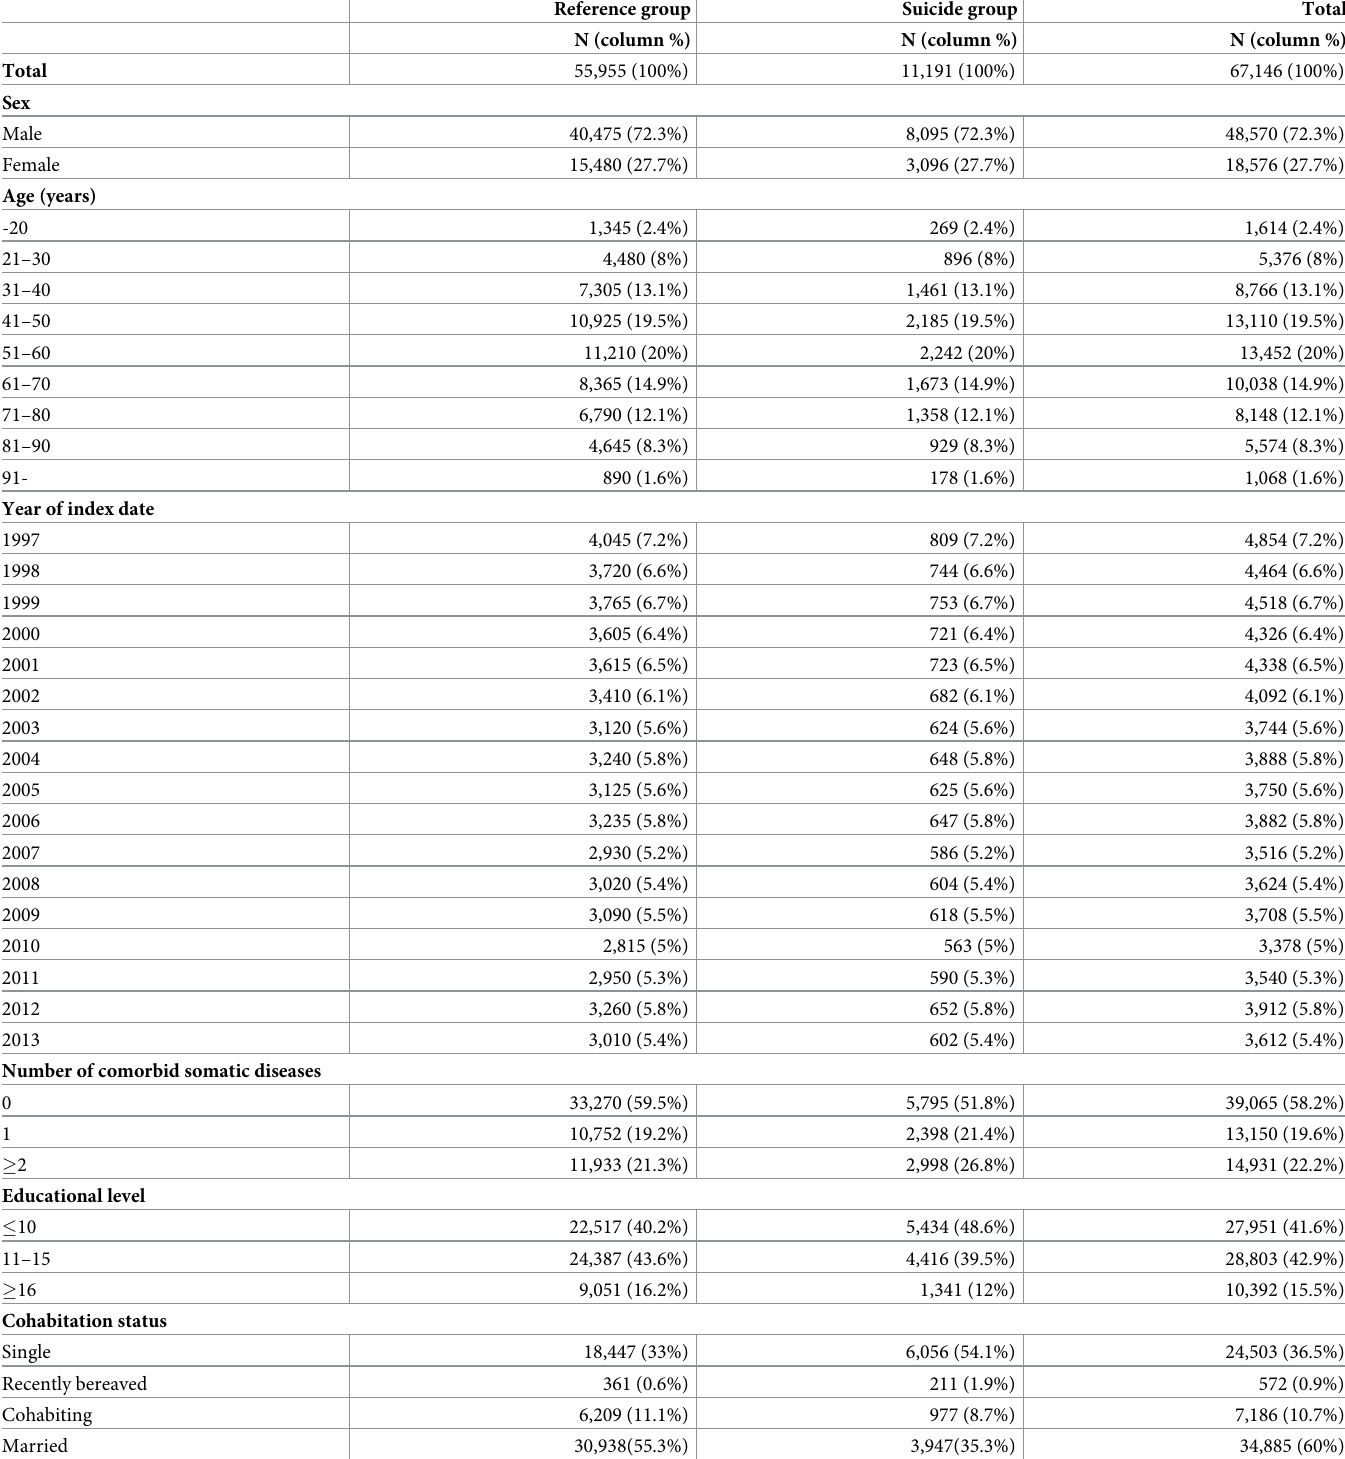
Table 1. Characteristics of the cohort one month before index